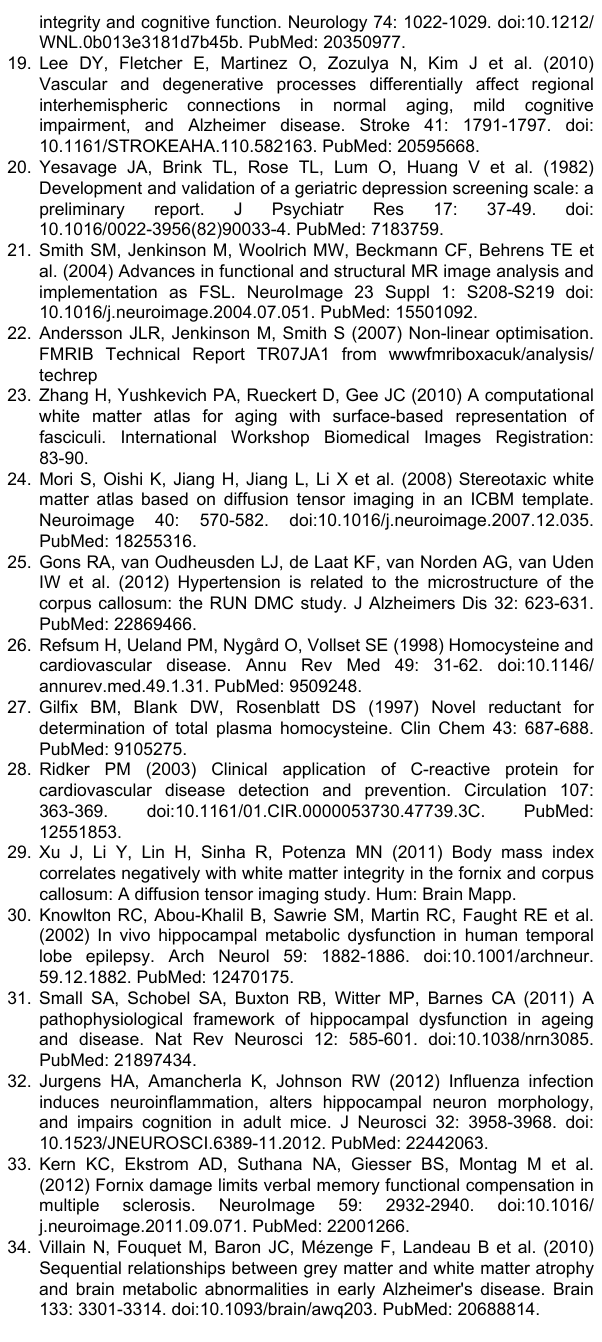
Table S1. Displays partial correlations ( r Mass Index (BMI) and white matter regions, controlling for age. Bolded r values reflect significant values with coefficients p greater than